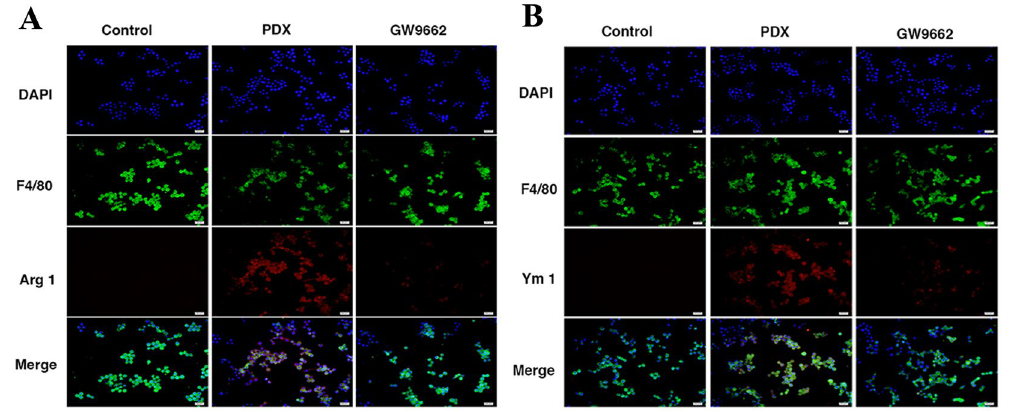
Figure 8. PDX induced M2 polarization in vitro. RAW264.7 cells were challenged with vehicle or PDX (1000 nM) in the absence or presence of GW9662 (1 µ M) for 24 hours. Macrophage marker F4/80 (pan marker, green) and M2 phenotype makers (Arg1 and Ym1) (red) were measured by immunofluorescence staining ( A , B ). Nuclei were stained with DAPI